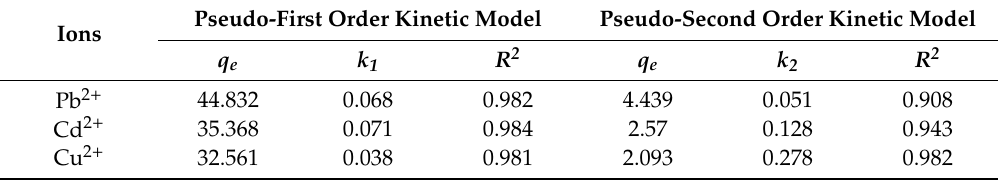
Table 6. Pseudo-first order kinetic model and pseudo-second order kinetic model